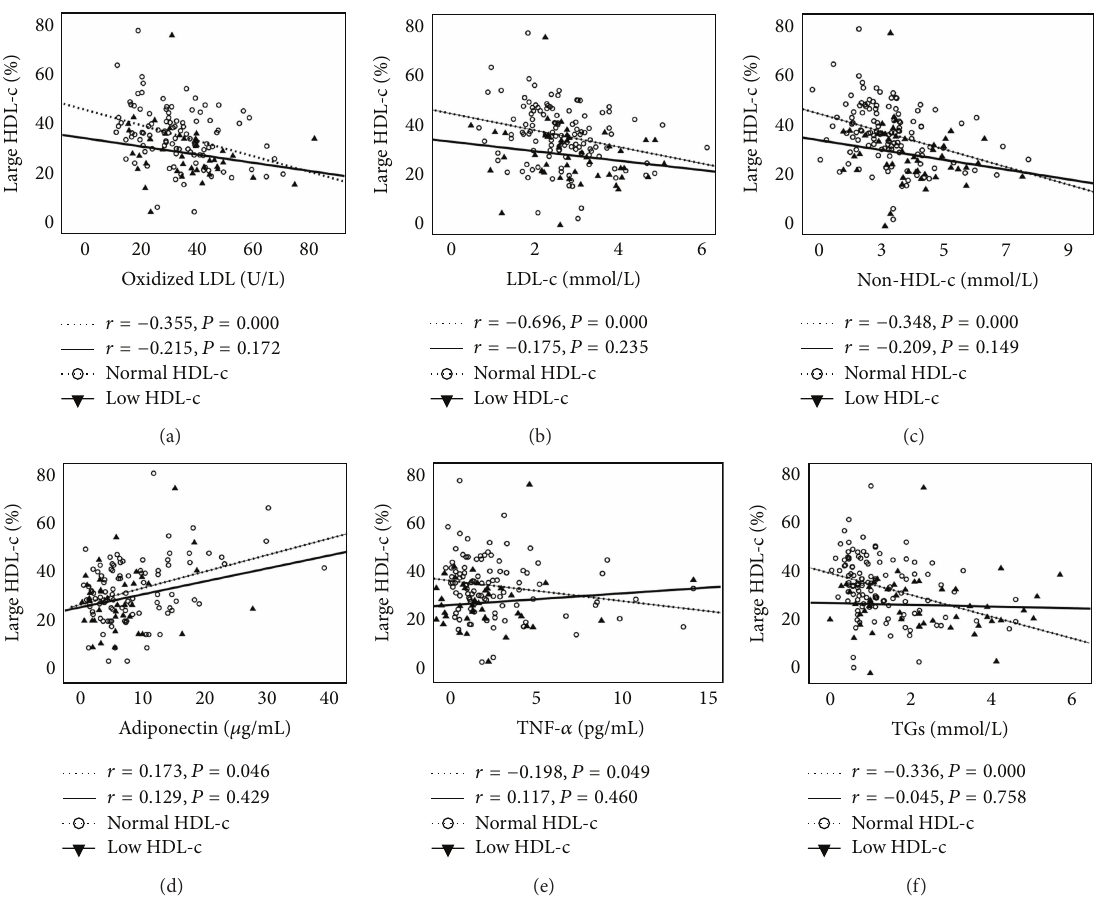
Figure 3: Main correlations in normal and low-HDL-c patients. Correlation between large HDL-c and Ox-LDL (a), LDL-c (b), non-HDL-c (c), adiponectin (d), TNF- 𝛼 (e), and TGs